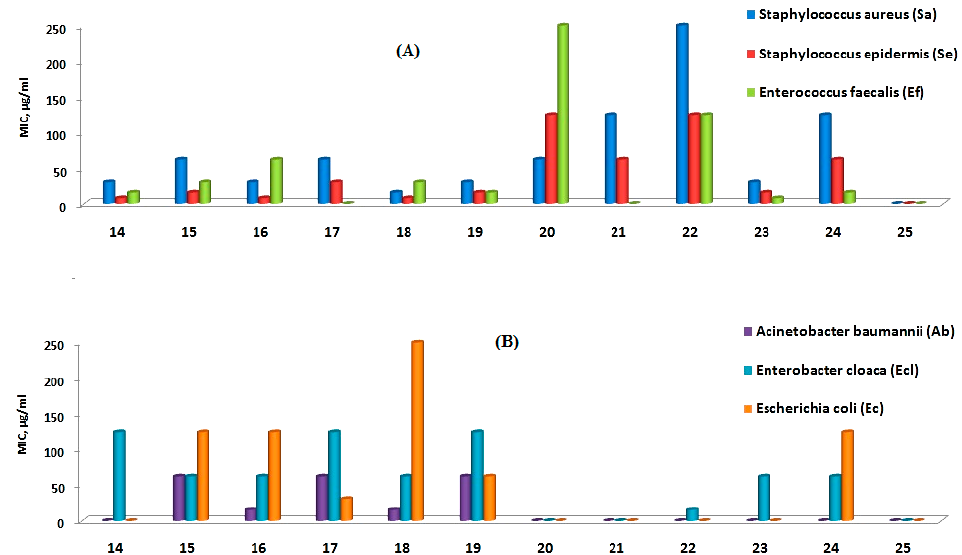
Figure 2. Minimal inhibitory concentrations (MIC, µg/mL) of Schiff bases 14 – 25 against multi-drug resistant bacteria ( A ) Gram-positive bacteria, ( B ) Gram-negative bacteria.